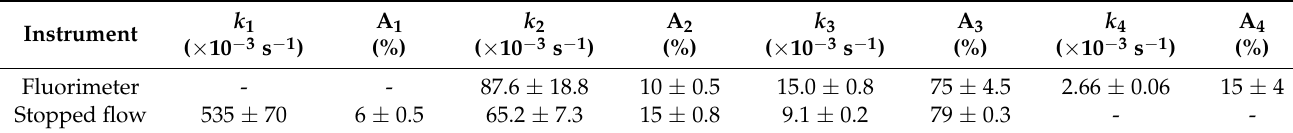
Figure 6. Dissociation kinetics of TCF7L2 I19A. ( A , B ) are representative dissociation traces for I19A obtained using the fluorimeter and the stopped-flow instrument, respectively. The data were fitted to one-, two-, and three-phase exponential functions, and the residuals are also shown (red, green, and blue, respectively). Experiments were performed in a PBS buffer, 1 mM DTT at 15 ◦ C. Table 2. Multi-phase dissociation kinetics of TCF7L2